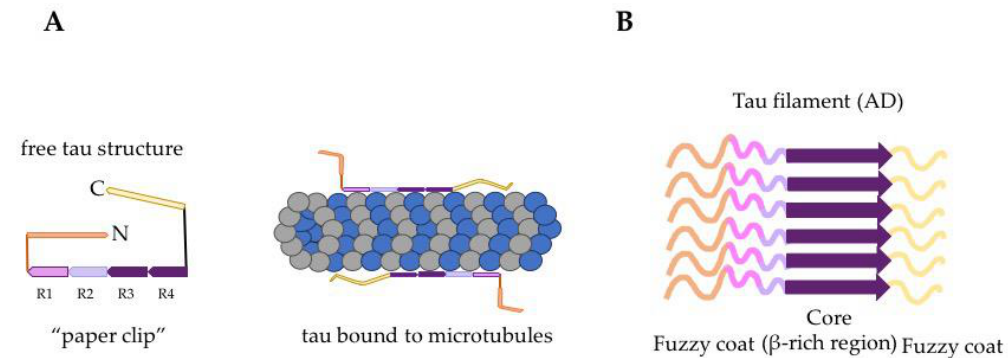
Figure 2. Possible tau structures. ( A ) The proposed “Paper-clip” structure of tau, in which both the N and C terminals are closely associated [141]. However, when tau is bound to microtubules, the two terminals are separated with the N -terminal projected away from the microtubules [124]. ( B ) In AD tau filaments, part of the tau repeat region (R3 and R4) forms the core of the filaments while R1, R2, and both N and C terminals form the “fuzzy coat” structure that surrounds the core (based on the Cryo-EM structure described in